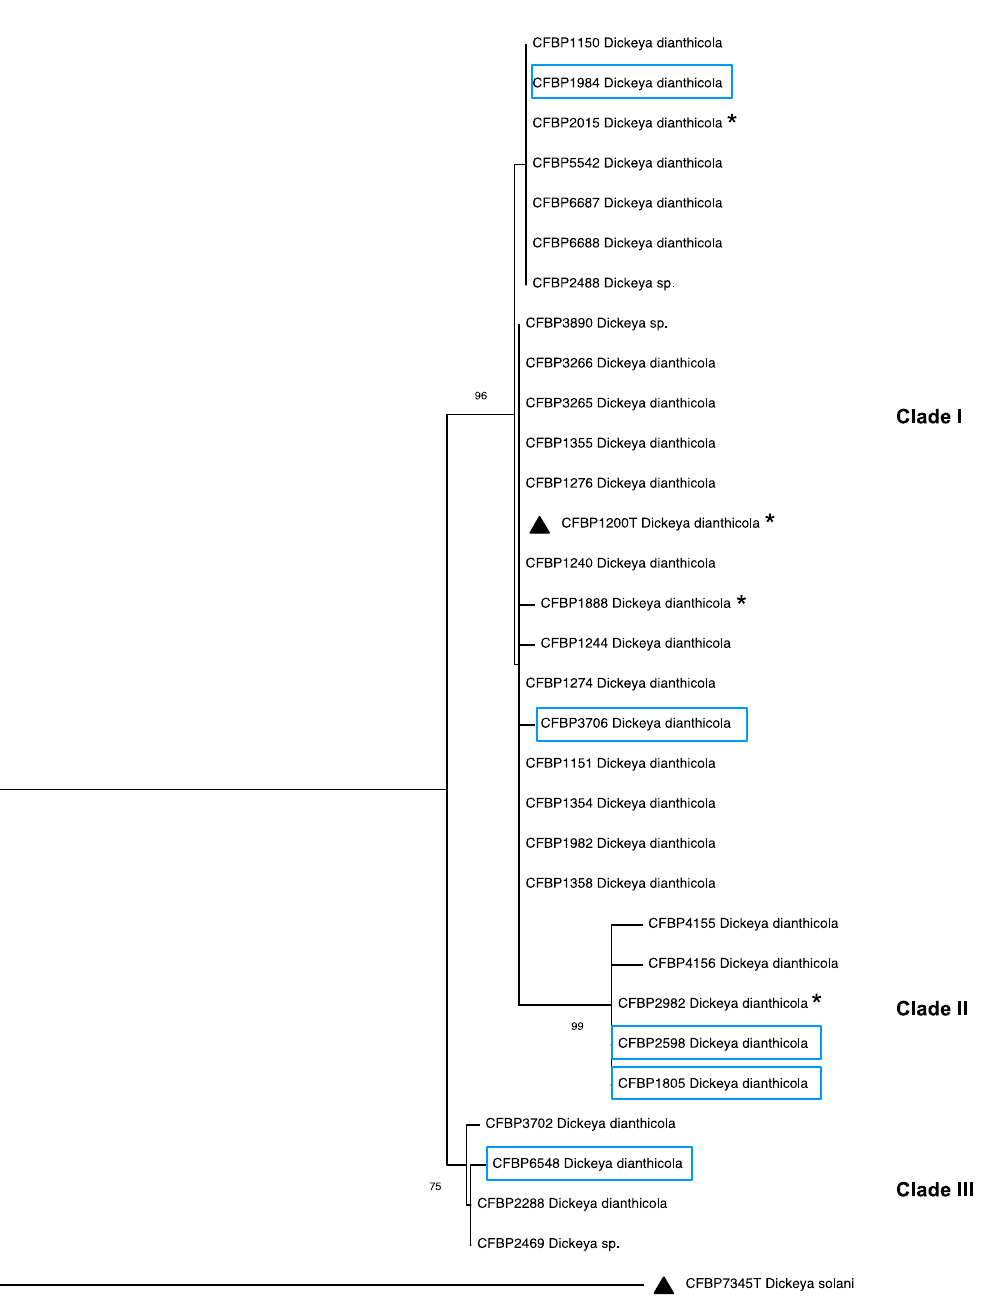
Figure 1. Phylogenetic tree of Dickeya dianthicola strains from CIRM-CFBP constructed from partial sequences from dnaX , leuS , and recA housekeeping genes. Strain D. solani CFBP 7345 was used as the outgroup. Bootstraps values are shown when superior to 70. The black triangles indicate the type strains. The strains identified by a star are strains for which a complete genome sequence already exists in the public databases. The strains in a square were chosen for complete genome sequencing in this